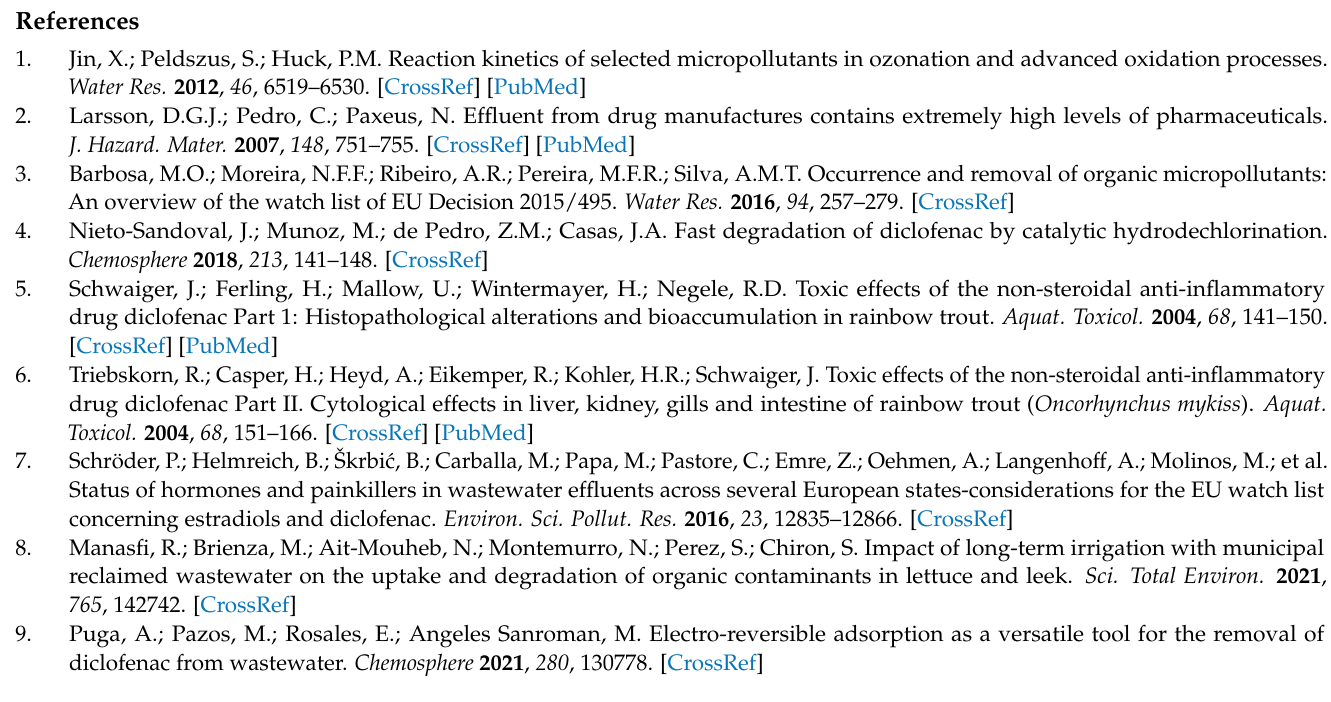
compared with run 7 in Table 1). Figure S12d: XRD of Ni slurry (cubic Ni0) obtained by action of NaOH/NaBH 4 (run No.15 in Table 1). Figure S13: Results of experiment No. 7, mentioned in Table 1 (0.4 mmol DCF + 4 mmol Al (in Al-Ni) + 20 mmol KOH). Experimental (symbols) and model fit (solid lines). Figure S14: Results of experiment No. 10 in Table 1 (0.4 mmol DCF + 4 mmol Al (in Al-Ni) + 10 mmol KOH). Experimental (symbols) and model fit (solid lines). Figure S15: Results of experiment No. 5 in Table 1 (0.4 mmol DCF + 4 mmol Al (in Al-Ni) + 40 mmol KOH). Experimental (symbols) and model fit (solid lines). Figure S16: Results of experiment No. 6 in Table 1 (0.4 mmol DCF + 4 mmol Al (in Al-Ni) + 30 mmol KOH). Experimental (symbols) and model fit (solid lines). Figure S17: Results of experiment No. 4 in Table 1 (0.4 mmol DCF + 5 mmol Al (in Al-Ni) + 25 mmol KOH). Experimental (symbols) and model fit (solid lines). Figure S18: Results of experiment No. 8 in Table 1 (0.4 mmol DCF + 4 mmol Al (in Al-Ni) + 5 mmol glucose + 20 mmol KOH). Experimental (symbols) and model fit (solid lines). Figure S19: Example of chromatogram from HPLC, experiment No. 3 from Table 1, reaction time 20 min. First signal corresponds to APA (retention time 3.2 min.), second to Cl-APA (retention time 4.5 min.) and third to DCF (retention time 5.9 min.). Table